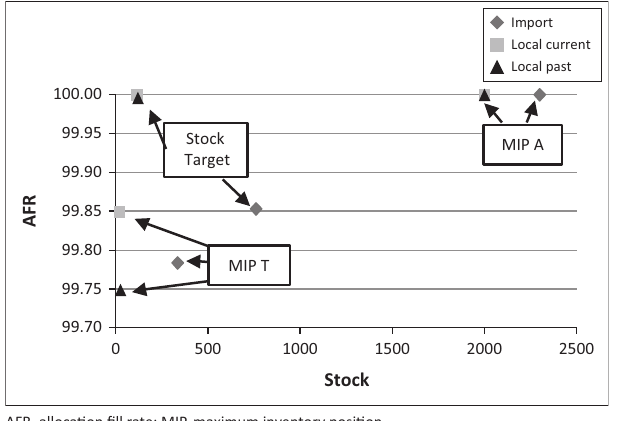
FIGURE 5: Comparison of the three order methods in a theoretical